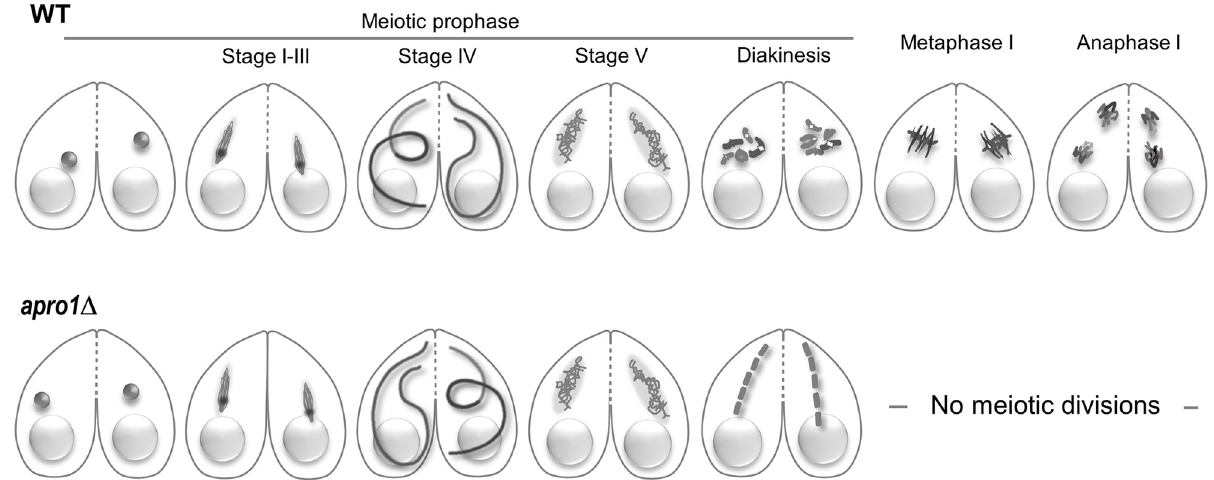
Fig 1. Schematic representation of meiosis in the wild type and apro1 Δ mutant. Wild-type meiosis is characterized by transient elongation of the germline nucleus during prophase. At metaphase I, condensed bivalents assemble at the nuclear equator. In the mutant, early prophase is normal, but by the end of prophase, condensed bivalents are aligned in tandem along the elongated nucleus; meiotic divisions do not take place.